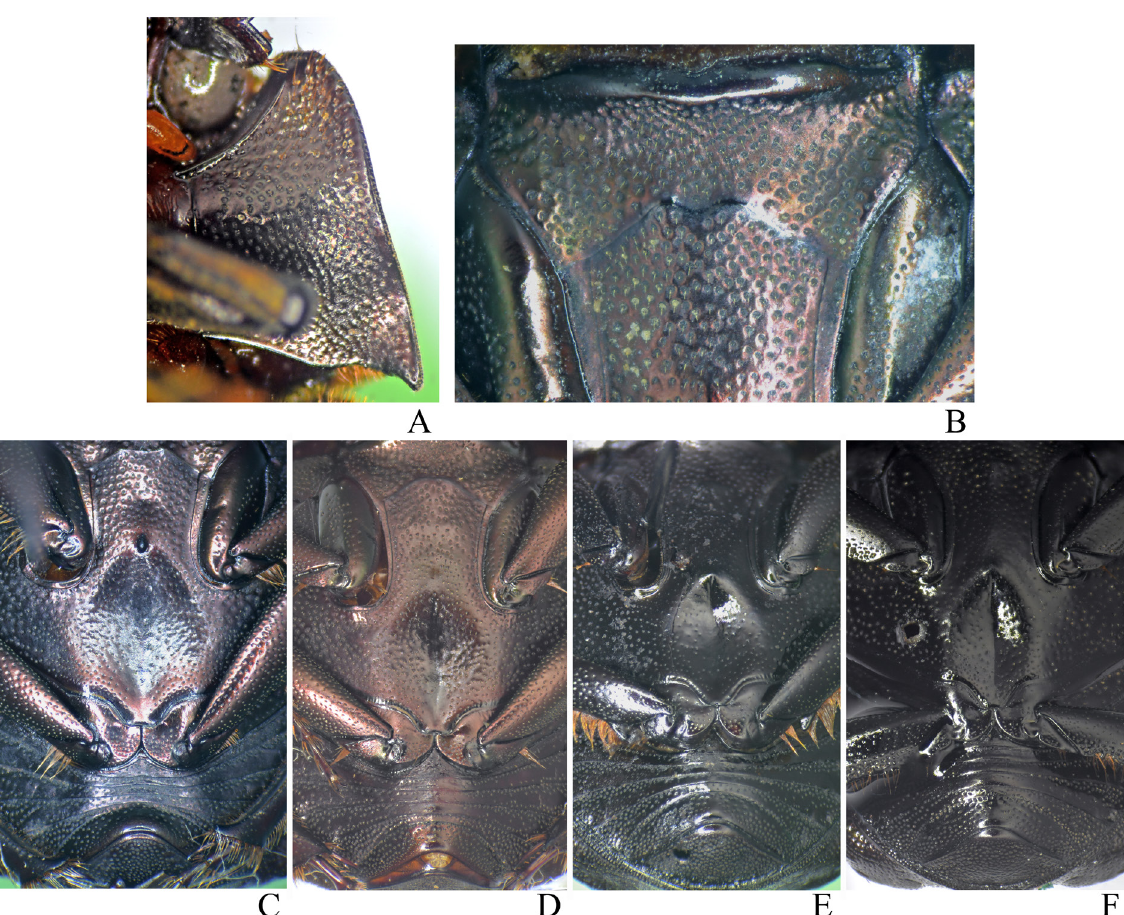
Fig. 13. Venter. A‒B . Streblopus opatroides van Lansberge, 1874. A . Hypomeron. B . Mesoventrite and anterior region of metaventrite. C‒F . Metaventrite and abdomen. C‒D . S. opatroides . C . ♂. D . ♀. E‒F . S. punctatus (Balthasar, 1938). E . ♂. F . ♀. Note in particular the distinction between the species and sexes in the shape of the concavity of the posterior region of the